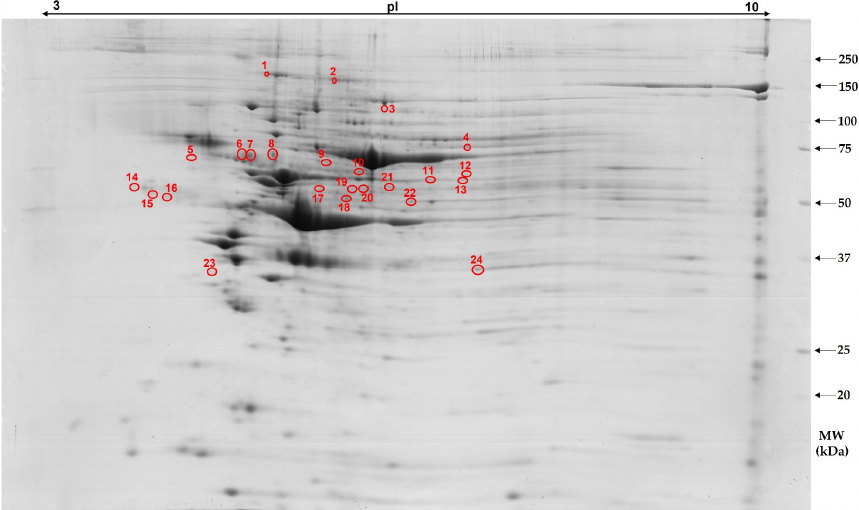
Figure 1. Representative two-dimensional electrophoresis gel image of porcine aorta proteome. Differentially expressed proteins between the animals fed standard diet (C) and experimental IN and CR diets are indicated by numbers. Protein spots numbers corresponds to those presented in the Table 3.